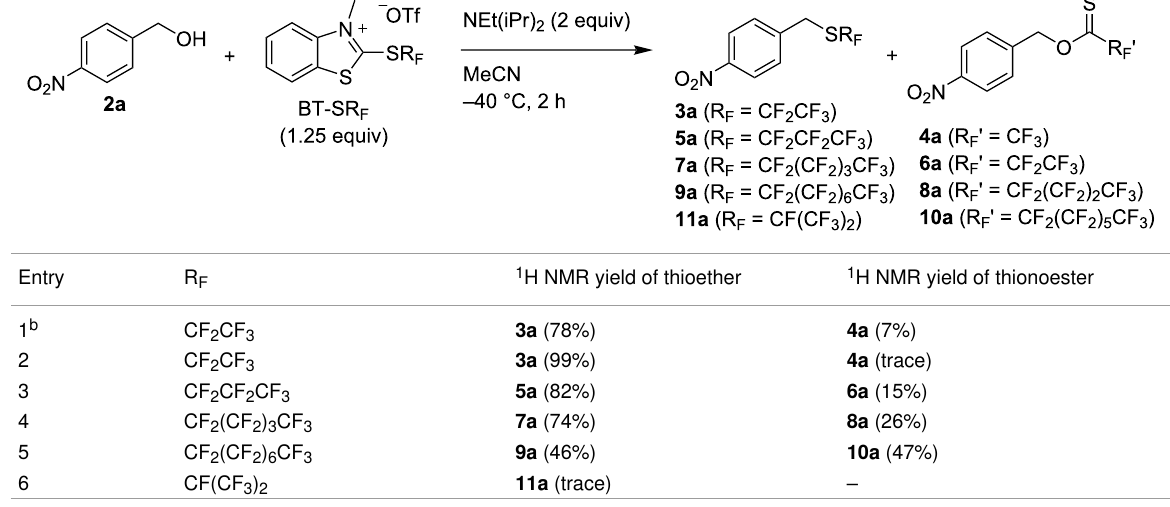
Table 1: Deoxygenative perfluoroalkylthiolation of alcohol 2a with BT-SR F reagents.